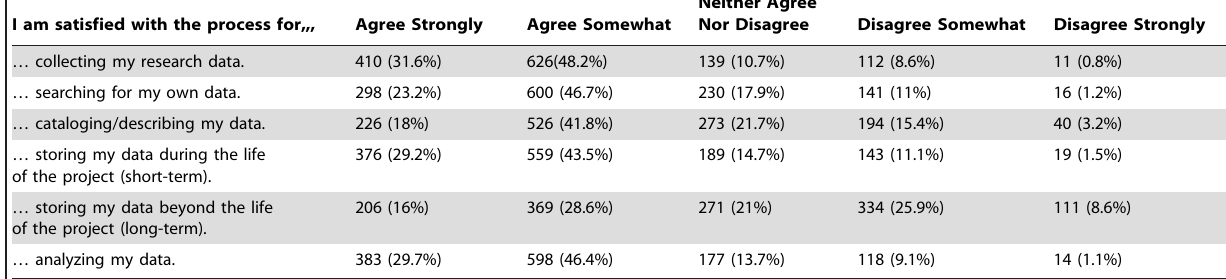
Table 5. Data issues.